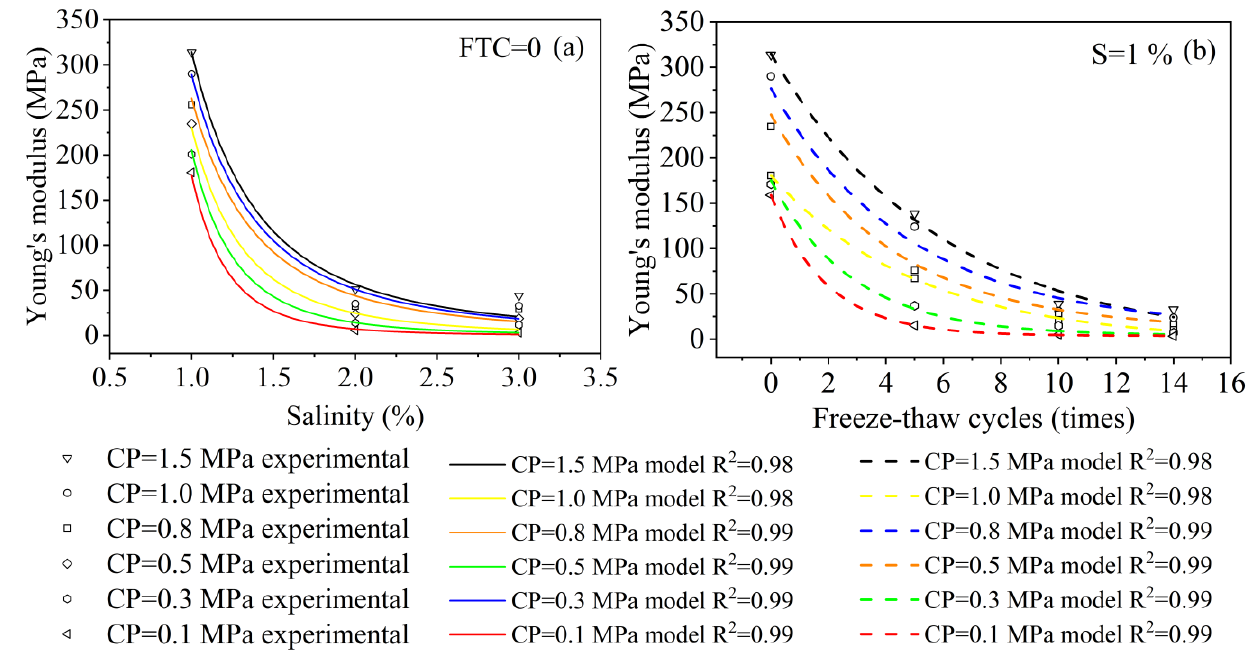
Figure 7. Comparison of test results and calculated results. Notes: FTCs represents freeze–thaw cycles, S represents salinity and CP represents confining pressure.